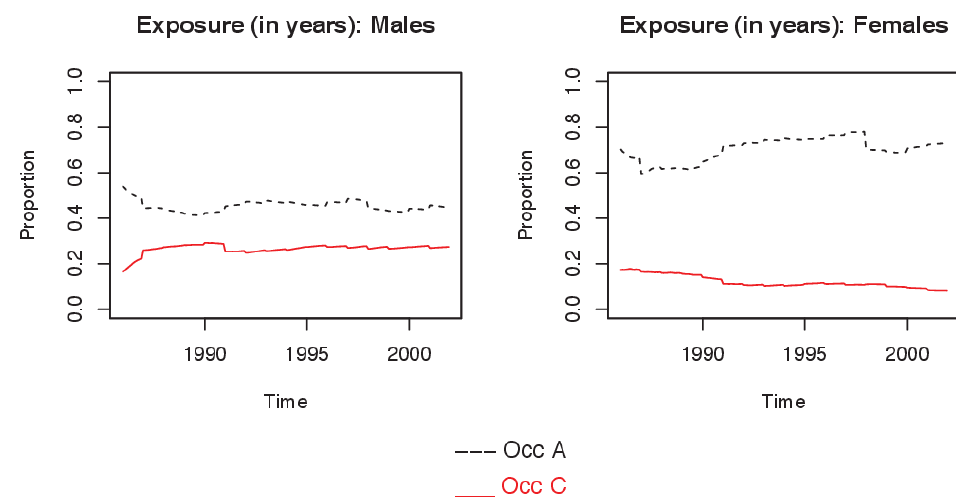
Figure A1. Insured Population by Occupation (Occ): Composition over time, by Claims and by Exposure.